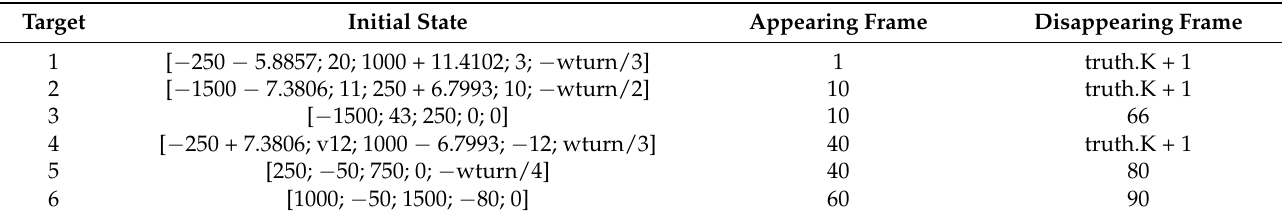
Table 3. Initial state of nonlinear Gaussian measurement model